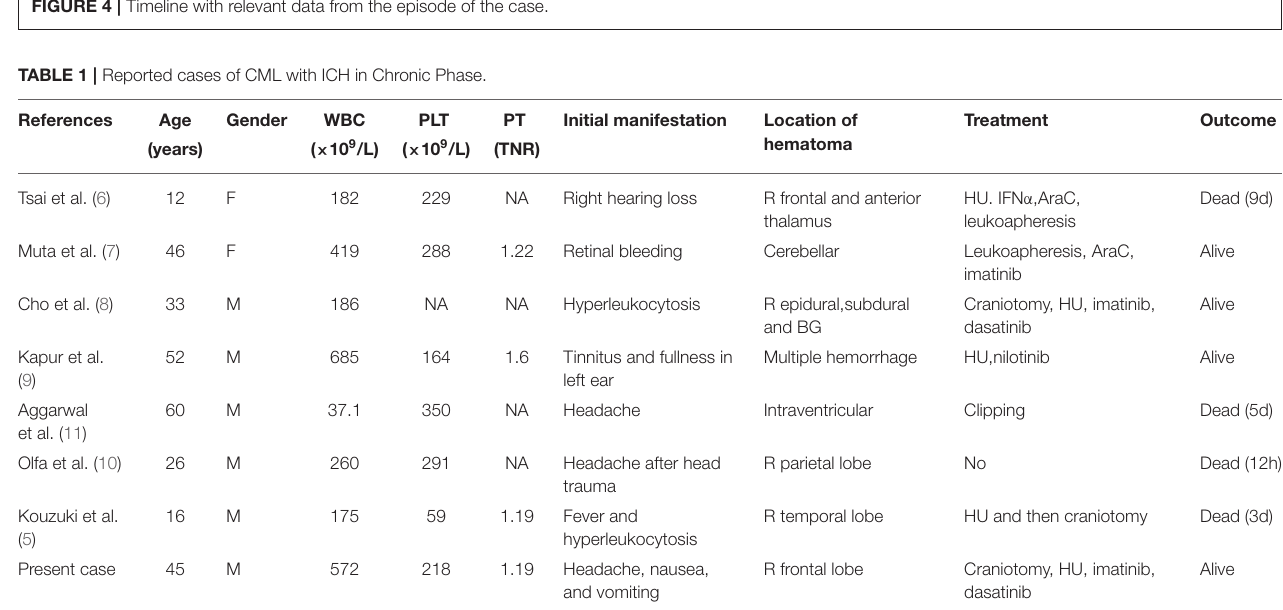
FIGURE 4 | Timeline with relevant data from the episode of the case.